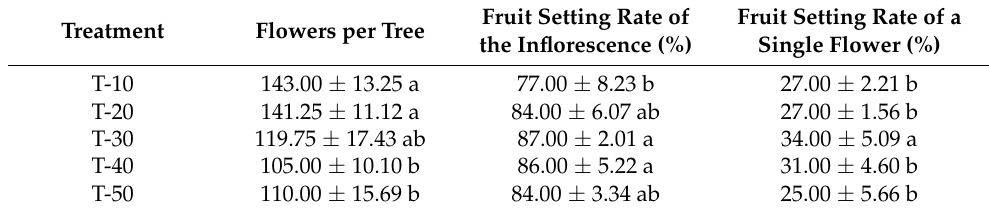
Table 4. Effects of dwarfing interstock length on flowering, and fruit-setting rates